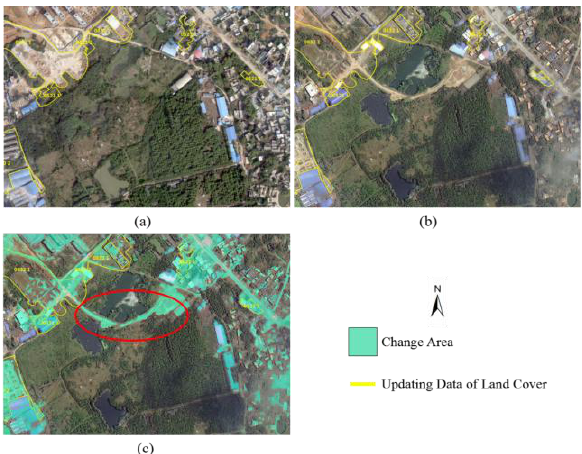
Figure 7. Missing update road inspection assisted by change detection results. (a) The previous image with updating data of land cover. (b) The new image with updating data of land cover.